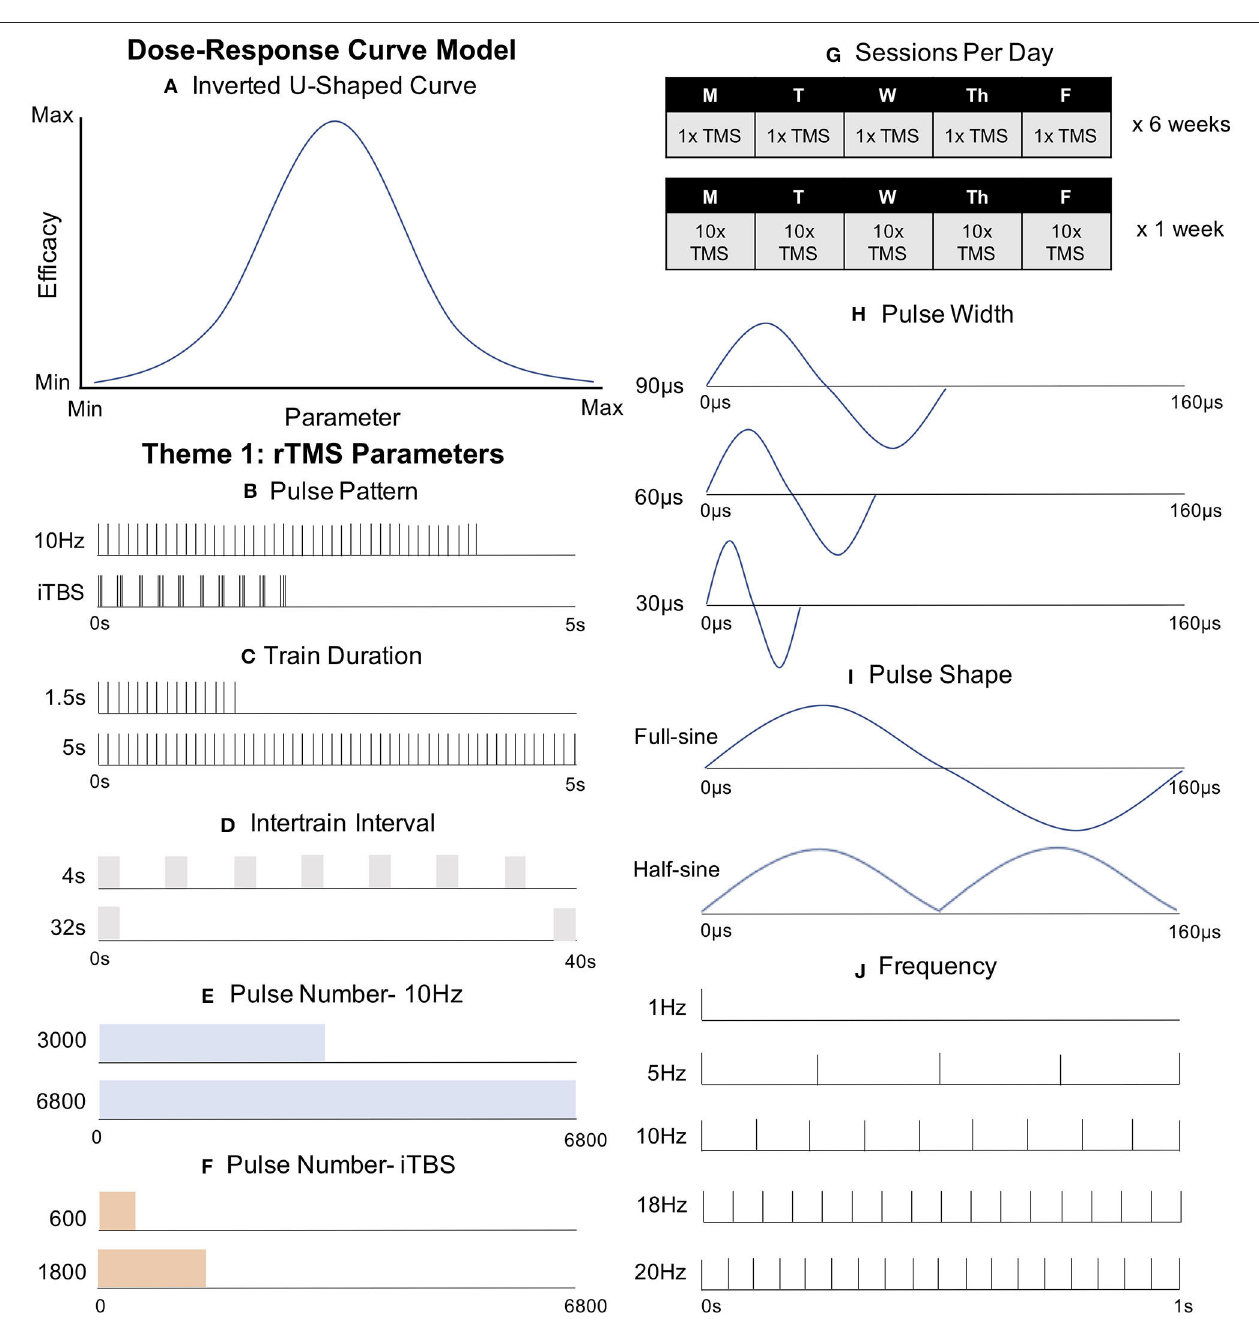
FIGURE 1 | Key rTMS Parameters Guiding the Development of Next Generation rTMS Therapies. (A) Dose-Response Curve Model. Some parameters follow an inverted U-shaped curve, with peak efficacy in the middle. (B) Pulse Pattern. Intermittent theta burst stimulation (iTBS) has been FDA-cleared as a clinically non-inferior, but more efficient, form of rTMS compared to conventional 10Hz stimulation. (C) Train Duration. Trains of 1.5s at 10Hz have produced the canonical excitatory effect while 5s trains at 10Hz produced an opposite inhibited effect. (D) Intertrain Interval (ITI). Decreased ITI has drastically reduced intracortical inhibition without changing corticospinal excitability or clinical depression outcomes. (E) Pulse Number-10Hz. 6,800 pulses of 10Hz rTMS did not improve clinical outcomes compared with conventional 3,000 pulse 10Hz rTMS. (F) Pulse Number- iTBS. Doubling pulse number (1,200) produced inhibitory effects, opposing the excitation from the FDA-cleared 600 pulse protocol. (G) Sessions Per Day. Relative to conventional rTMS ( top ) “Accelerated rTMS” (applying more than one session per day, bottom ), may produce a more rapid and effective clinical response. (H) Pulse Width. Longer pulse widths may produce more efficient cortical activation. (I) Pulse Shape. Full-sine (biphasic) waveforms appear to produce stronger stimulation than single or summated half-sine (monophasic) pulses. (J) Frequency. Despite extensive clinical investigation, various stimulation frequencies (including 20, 18, 10, and 5Hz to the left DLPFC and 1Hz to the right DLPFC) have not revealed a superior frequency at the group